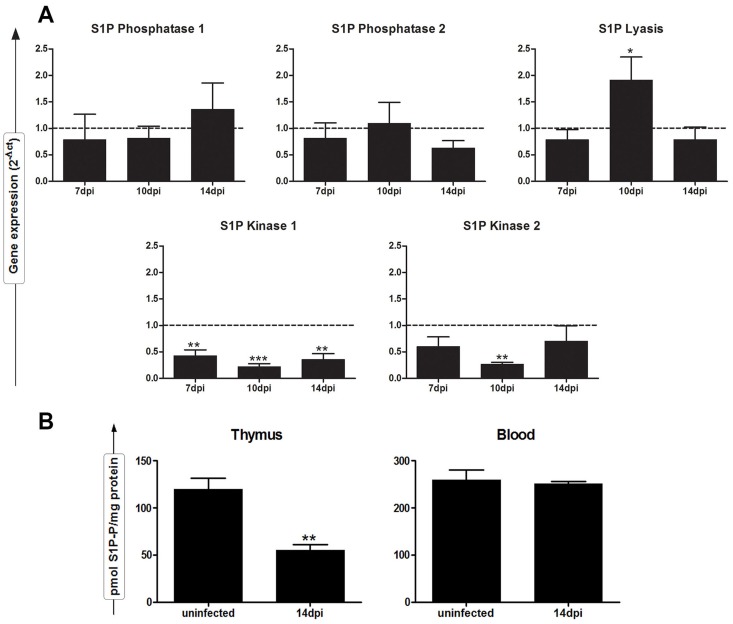
Down-modulation of intrathymic levels of S1P kinase activity in T. cruzi acutely-infected mice is associated with catabolic gene expression of the S1P pathway.Thymuses were collected from normal or T. cruzi-infected BALB/c on days 7, 10 and 14 post-infection (dpi) for measurements of the expression of S1P metabolic genes by real-time PCR and the levels of S1P levels by TLC. (A) mRNA levels of murine S1P kinases (SPHK1/2), S1P phosphatases (SGPP1/2) and the S1P lyase (SGPL1) from normal and T. cruzi-infected thymuses. Quantitative PCR results were normalized to values obtained from uninfected thymuses. Gene expression was assessed by comparing the expression of each to the normalizer GAPDH using the Ct method and is represented as mean ± SE of three independent experiments (n = 3 mice per group). (B) S1P kinase activity in thymuses and sera from normal or infected mice were measured by TLC, as described in Materials and Methods. C17-S1P was used as the internal standard. Graphs show the average values from two independent experiments (n = 6 mice per group), with error bars representing the standard error. Differences between uninfected and infected mice are significant * (p<0.05), ** (p<0.01), *** (p<0.001).